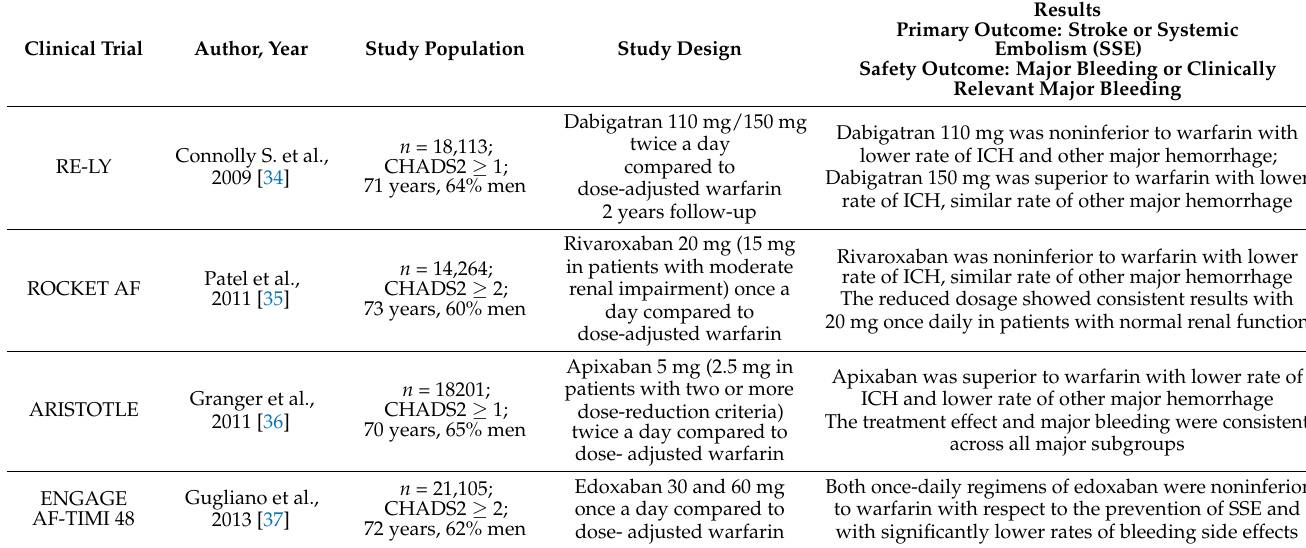
Table 2. Phase III clinical trials demonstrating the safety and efficacy of NOACs compared to VKA for stroke prevention in patients with